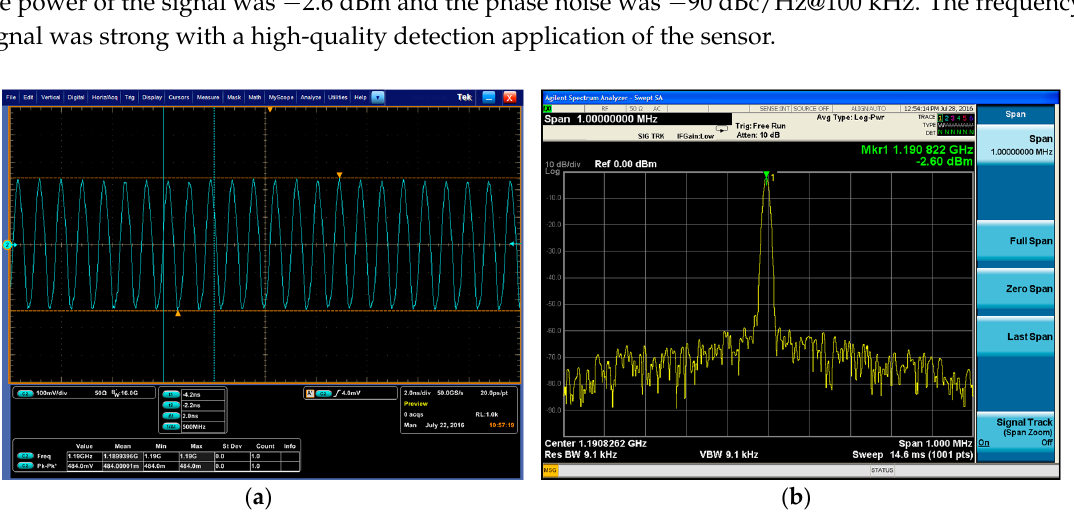
Figure 6. Detection of the signal output from the sensor sample: ( a ) oscillogram; ( b ) spectrum.